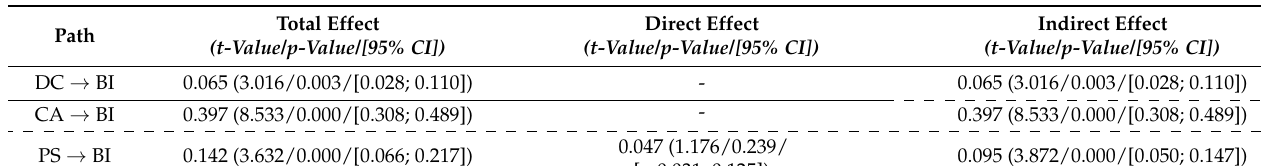
Table 2. Bootstrapping results of the UTAUT